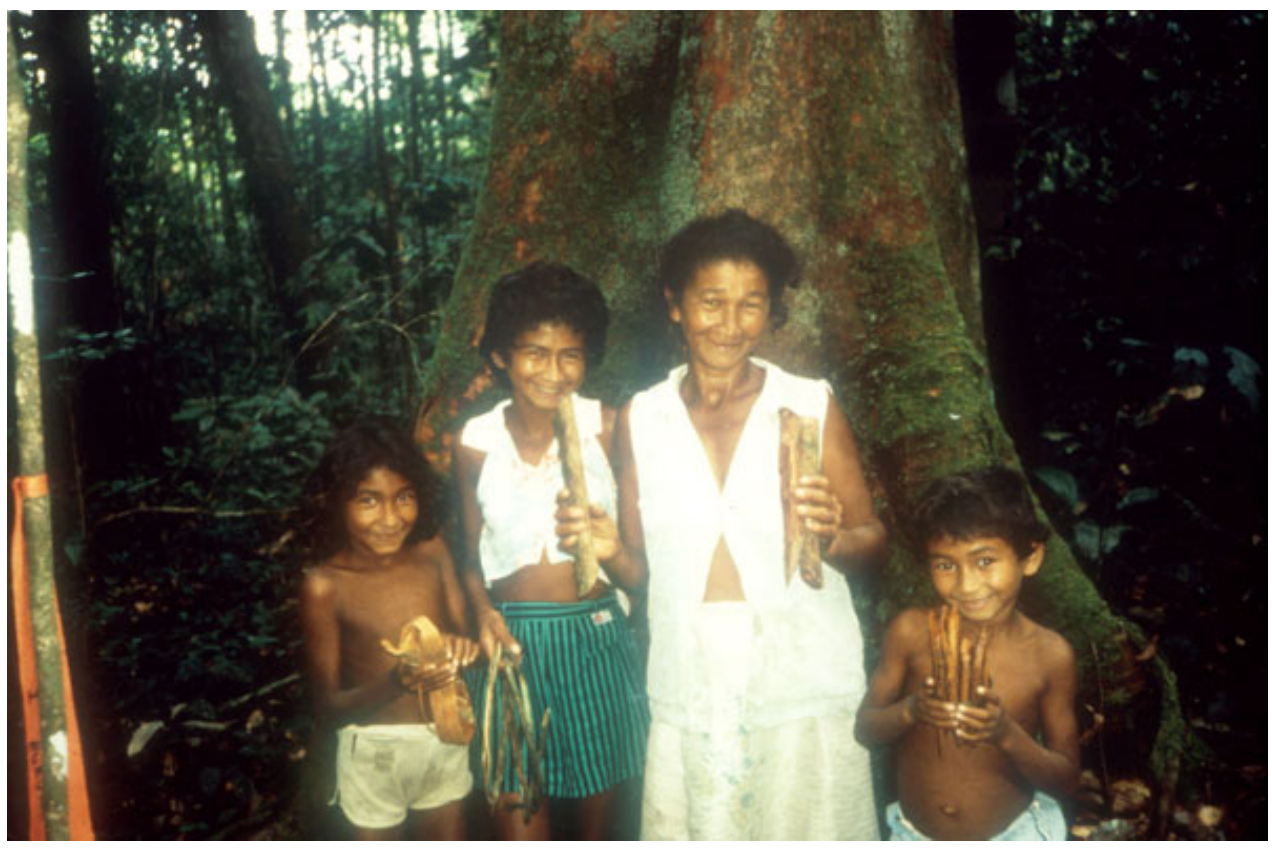
Fig. 10. Maria Brito and her children collect medicinal bark in their family forest reserve. Photo: Patricia